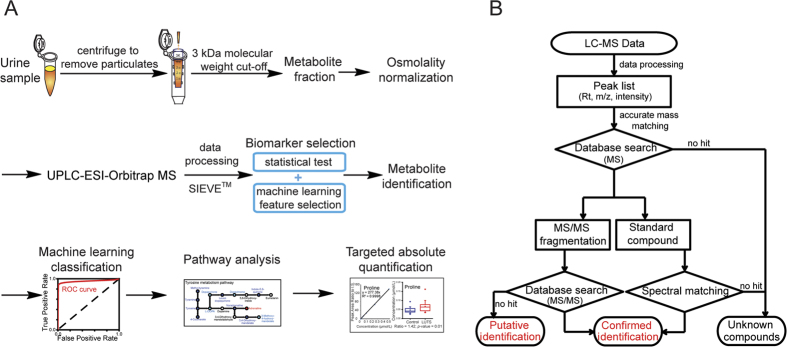
Comprehensive workflow of urinary metabolite biomarker discovery of LUTS (A) and flowchart of metabolite identification process (B). Accurate mass matching with multiple online databases was conducted with a mass error ∆ppm < 5. Because there are much fewer entries in MS/MS metabolite database compared to MS database, features with matching results in MS but not in MS/MS databases were considered putative identifications.